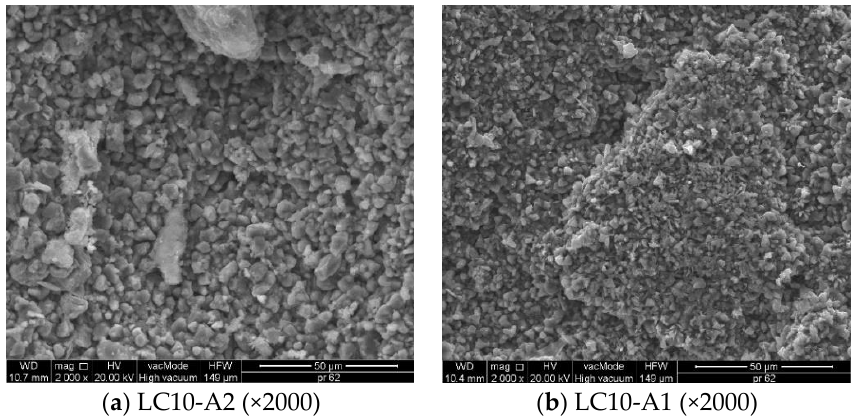
Figure 9. SEM microstructure of the coatings: ( a ) A2; ( b ) A1 at 2000 times magnification. ( a ) LC10-A2 (×2000); ( b ) LC10-A1 (×2000).